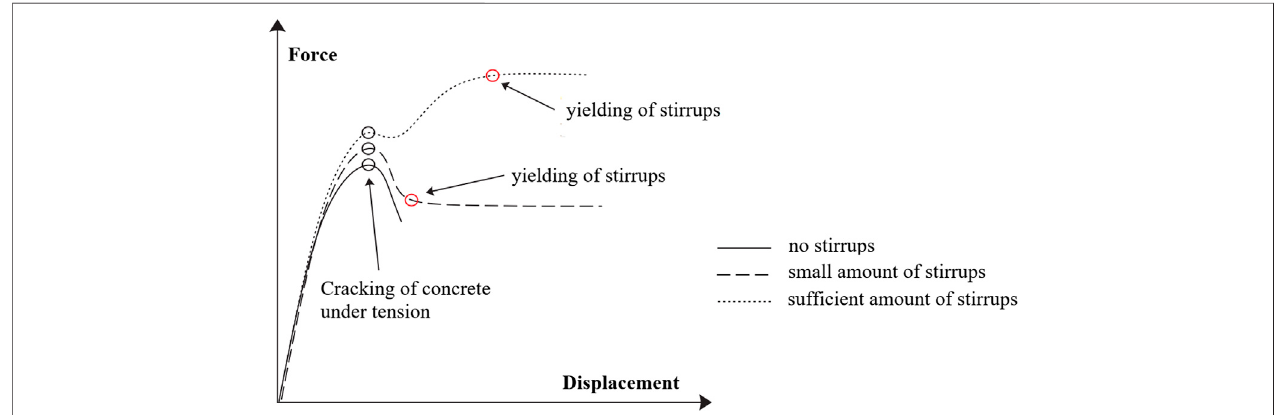
FIGURE 2 | Force – displacement diagram of beam-column dowel connections with eccentrically placed dowel.